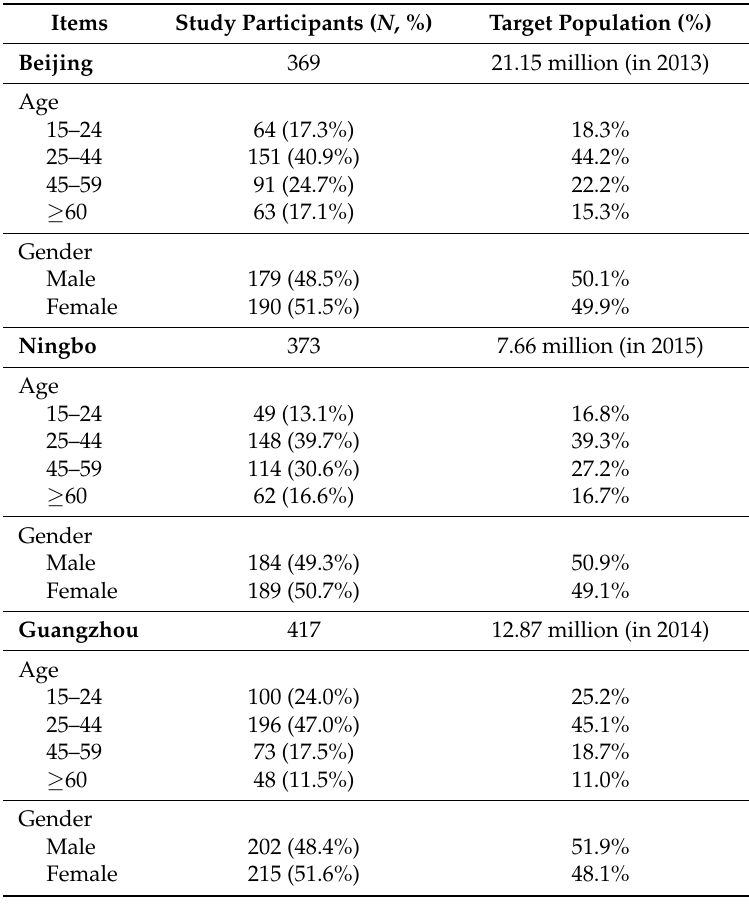
Table 1. Demographic information of the sample versus the target total population of each studied city. Items Study Participants ( N , %) Target Population